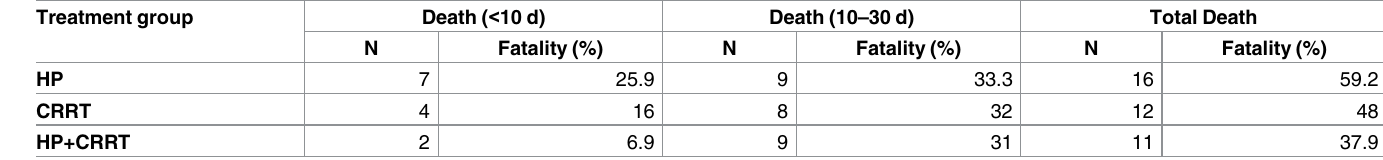
Table 5. Fatality times and rates of paraquat-poisoned patients with high plasma paraquat levels (1,000–5,000 ng/mL, n = 81). Treatment group